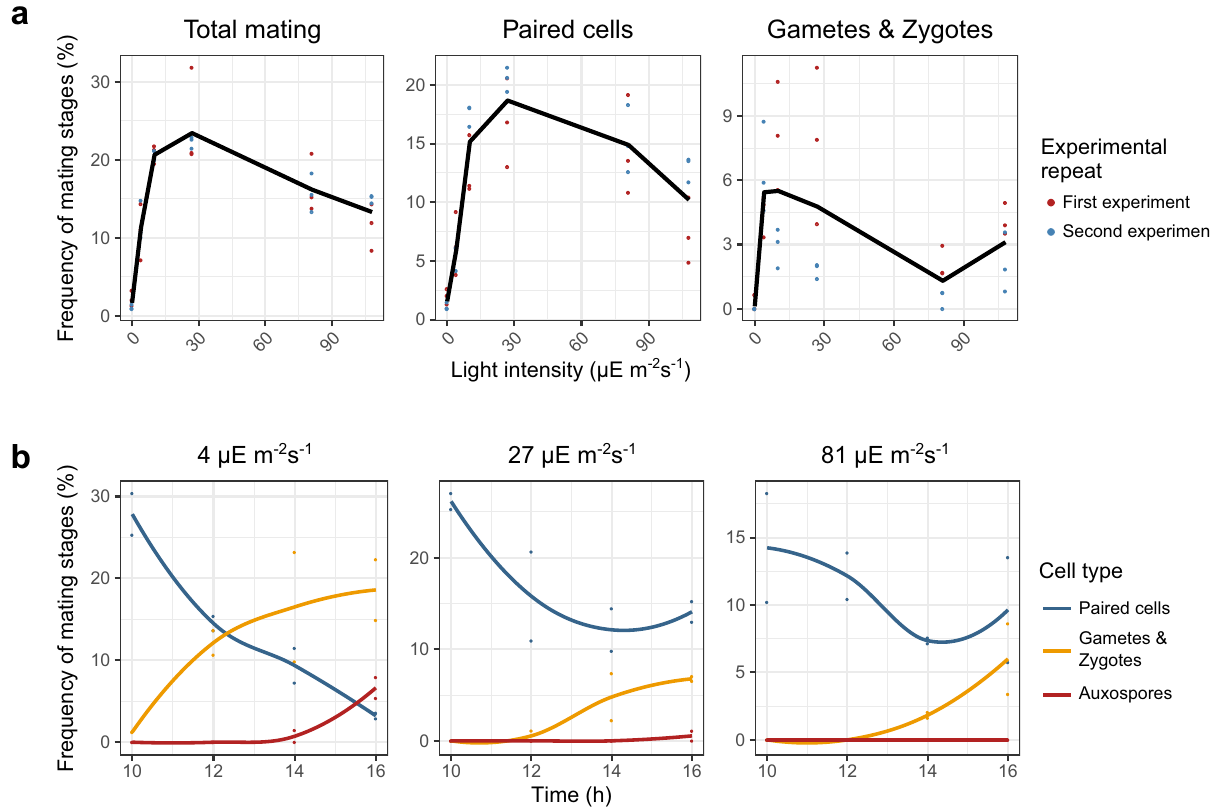
Figure 1. Influence of light intensity on sexual reproduction. ( a ) Influence of light intensity on the frequency of mating cell stages after 14 h of illumination. The experiment was performed twice, as indicated with colours. Dots represent frequency (in %) of sexual cells relative to all cell types (vegetative + sexual), while solid lines connect averages of both experiments. Confidence intervals for all pairwise combinations of intensities are visualized in Supplementary Fig. S1. ( b ) Time series showing the frequency of sexual cell stages over a period of 6 h after treatment with different light intensities (4, 27 and 81 µE m −2 s −1 ). Individual data points are represented by dots and the average percentage is connected by a Loess smoothed line. Different sexual cell stages are shown with different